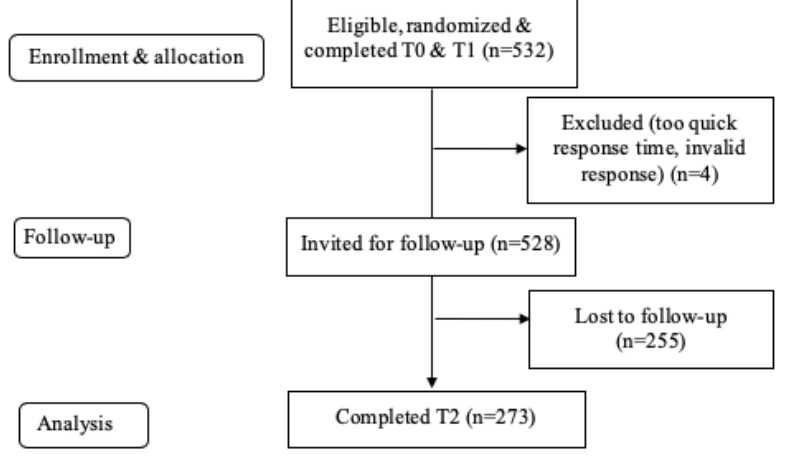
Figure 2. Flow chart of participants. T0, enrollment, allocation, and baseline measurements; T1, measurement of perceived relevance; T2, measurement of motivation, attitude toward smoking cessation, social influence, self-efficacy, smoking